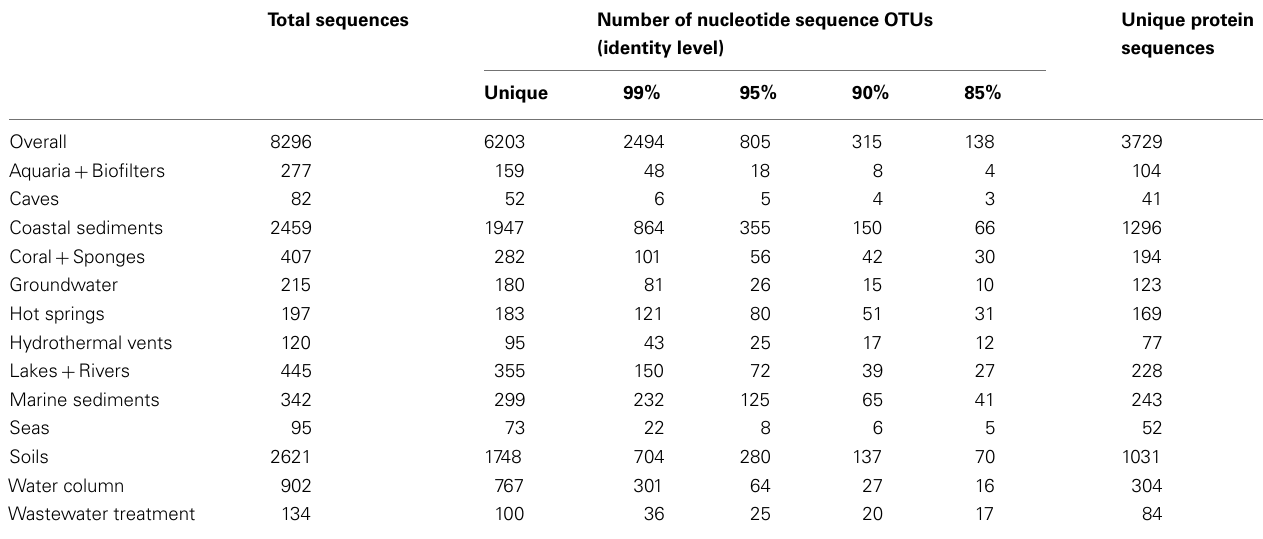
Table 1 | Summary statistics for theAOA amoA sequence